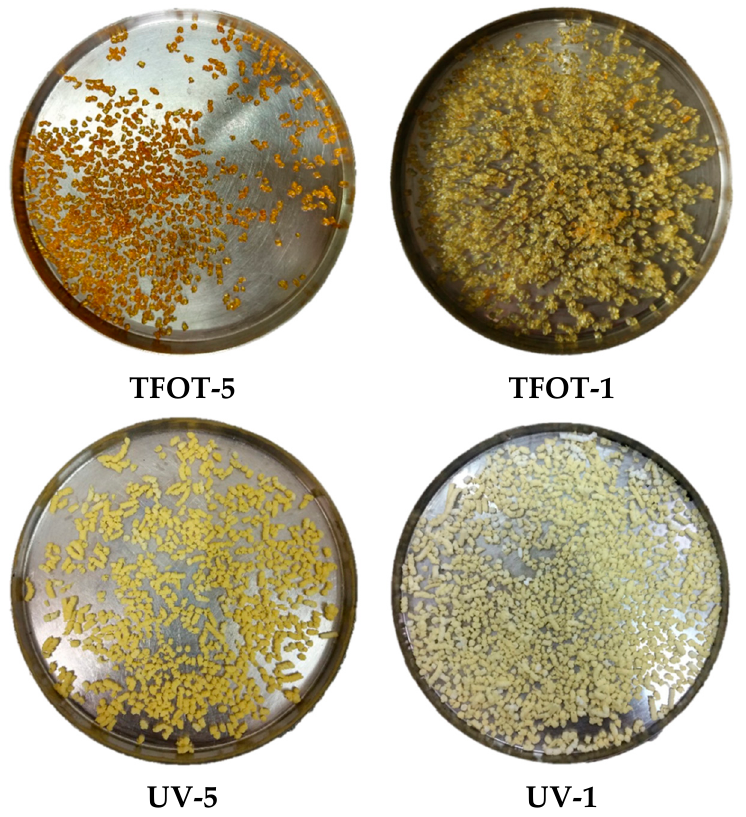
Figure 7. Appearance of aged SBS copolymers.